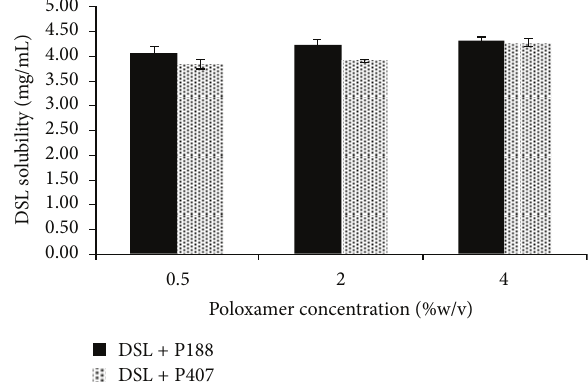
Figure2:SaturatedsolubilitystudyofDSLinpresenceofpoloxamer P188 and